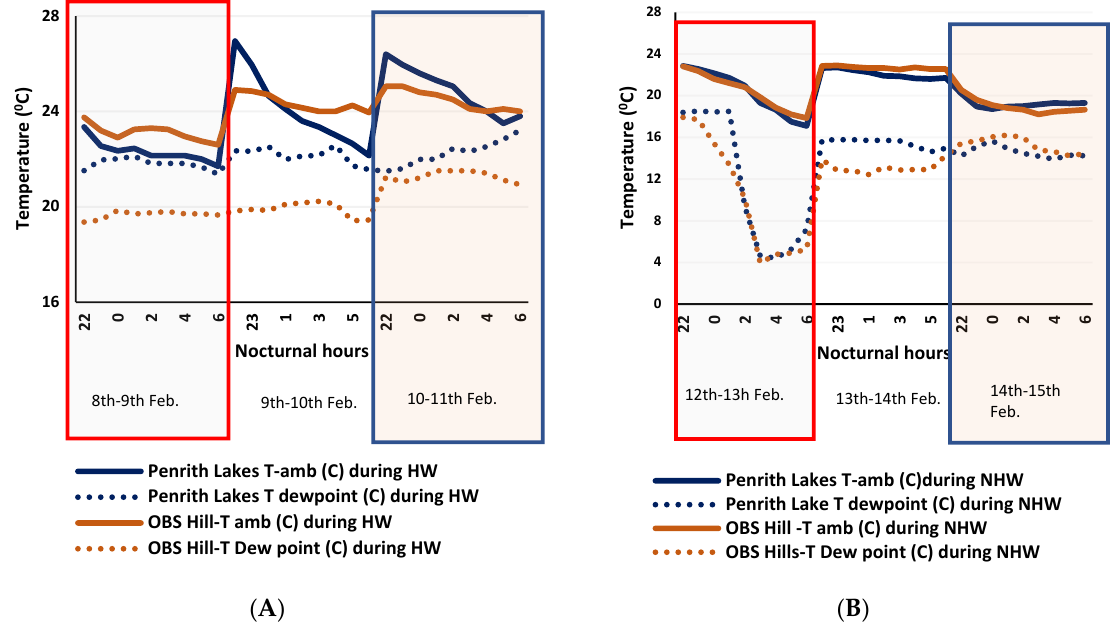
Figure 6. Nocturnal ambient temperatures & dew point temperatures at Penrith Lakes & OBS Hill during HW (9–11 February 2017) and NHW periods. ( A ) during the HW and ( B ) NHW